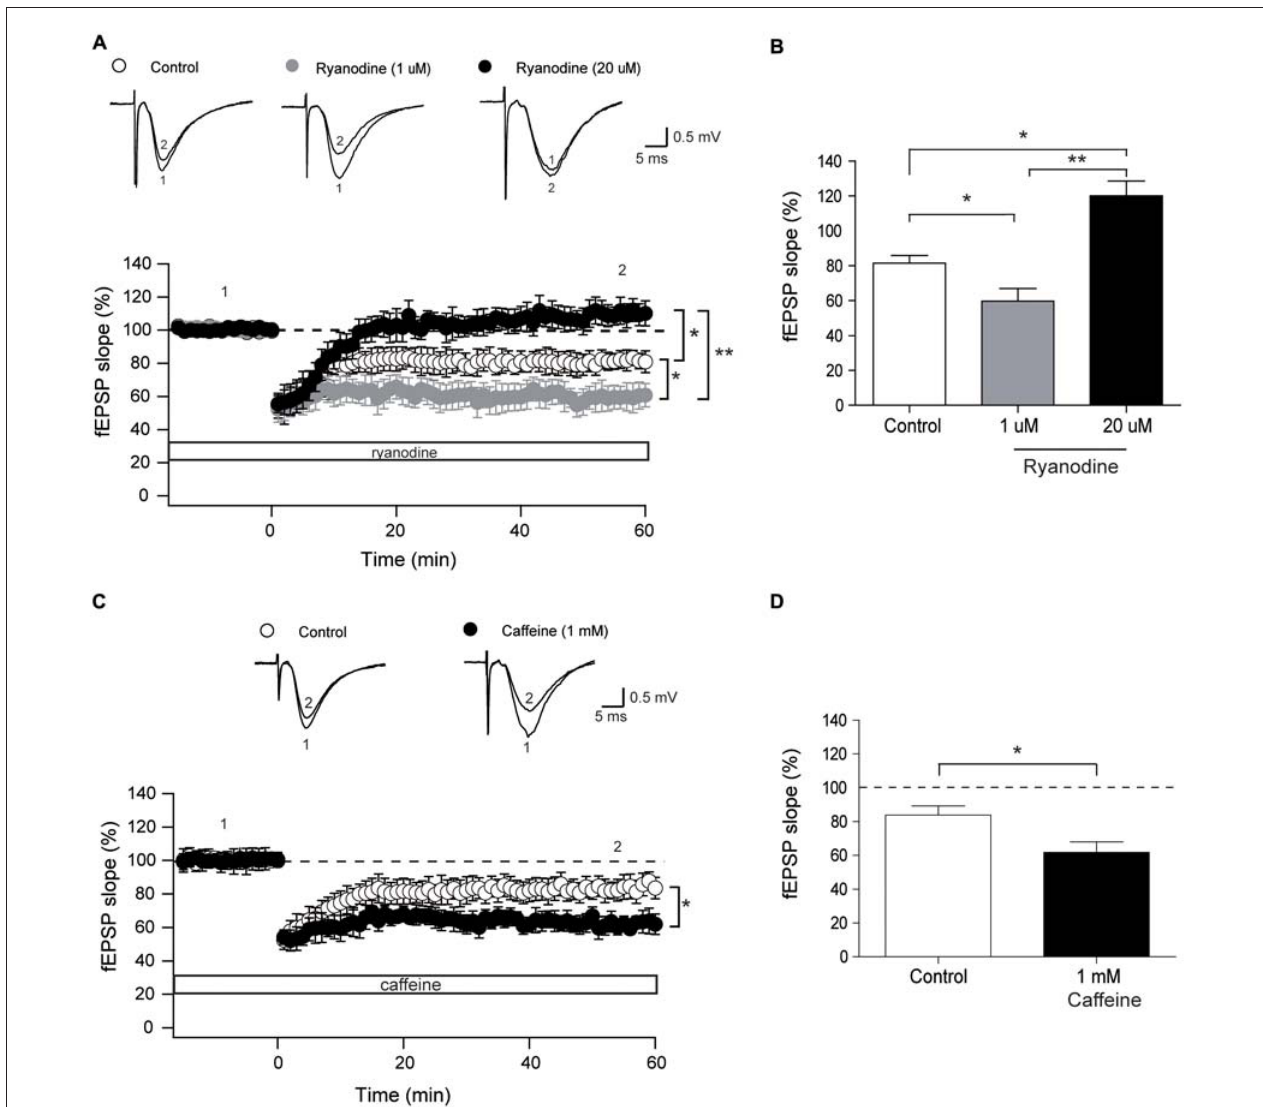
FIGURE 4 | Stimulatory and inhibitory ryanodine concentrations and caffeine modify the long-term depression (LTD) response. (A) Time course of fEPSP slopes recorded (CA3–CA1) before and after application of the low frequency stimulation (LFS) protocol to control hippocampal slices (14, 4) or to slices treated with 1 µ M ryanodine (14, 3) or 20 µ M ryanodine (13, 4). Representative fEPSP traces recorded 1–5 min before (trace 1) and 60 min after applying the LFS protocol (trace 2) to control slices, or recorded in slices treated with 1 µ M or 20 µ M ryanodine are shown on top of the graph. Open symbols: control slices; gray symbols: slices treated with 1 µ M ryanodine; black symbols: slices treated with 20 µ M ryanodine. (B) Average magnitudes of fEPSP slopes recorded during the last 10 min after stimulation. (C) Time course of fEPSP slopes recorded (CA3–CA1) before and after application of the LFS protocol to control hippocampal slices (15, 3) or to slices treated with 1 mM caffeine (12, 4). The first number in parentheses indicates the number of hippocampal slices and the second the number of animals used. Representative fEPSP traces recorded 1–5 min before (trace 1) and 60 min (trace 2) after applying the LFS protocol to control slices and to slices treated with 1 mM caffeine are shown on top of the graph. Open symbols: control slices; black symbols: slices treated with 1 mM caffeine. (D) Average magnitudes of fEPSP slopes recorded during the last 10 min after stimulation of control or caffeine-treated slices. Values represent Mean ± SE. Statistical significance of values was assessed by Mann-Whitney test ( ∗ p < 0.05; ∗∗ p <